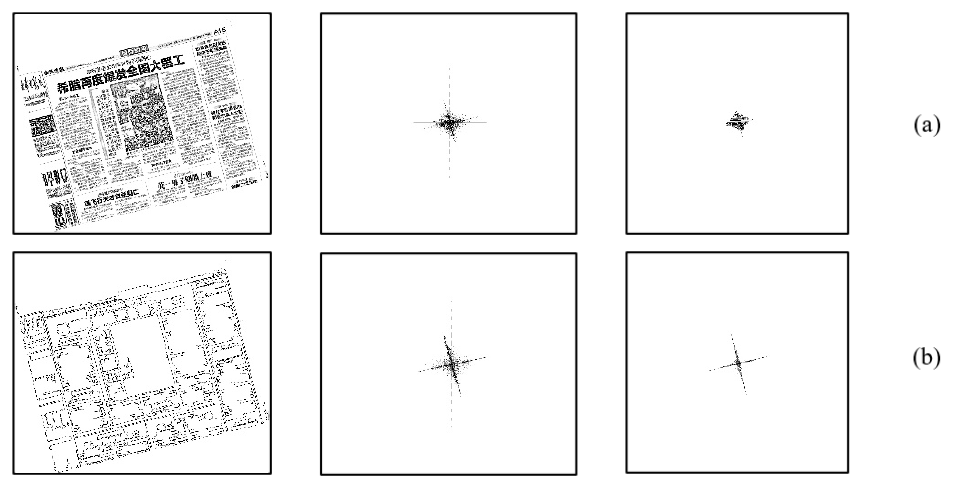
Figure 6. The comparison of frequency domain diagram. ( a ) Without morphological treatment. ( b ) After morphological processing. The upper part on the left side is the original image, and the lower part on the left side is the morphological clustering image. In the middle position are the frequency domain images. The images on the right side are binary images in frequency domain space.